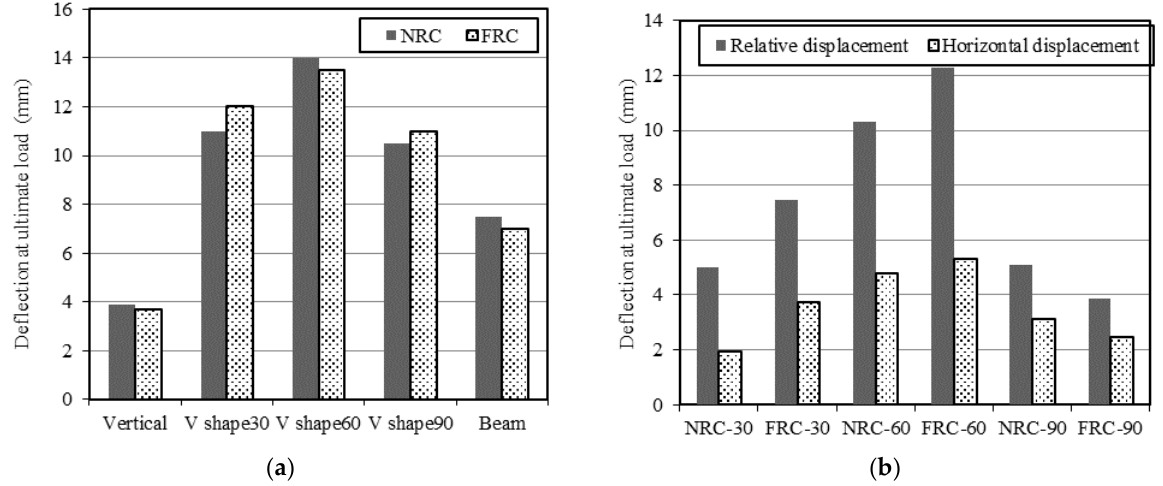
Figure 19. Percentage increase in the ultimate loads of FRC specimens compared to the correspond- ing NRC specimens.